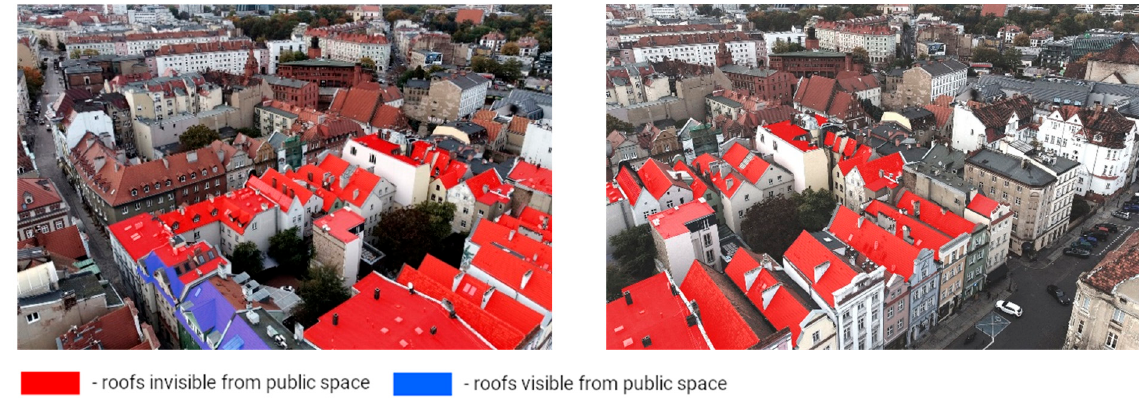
Figure 18. Roofs visible from the public space surrounding the building block.